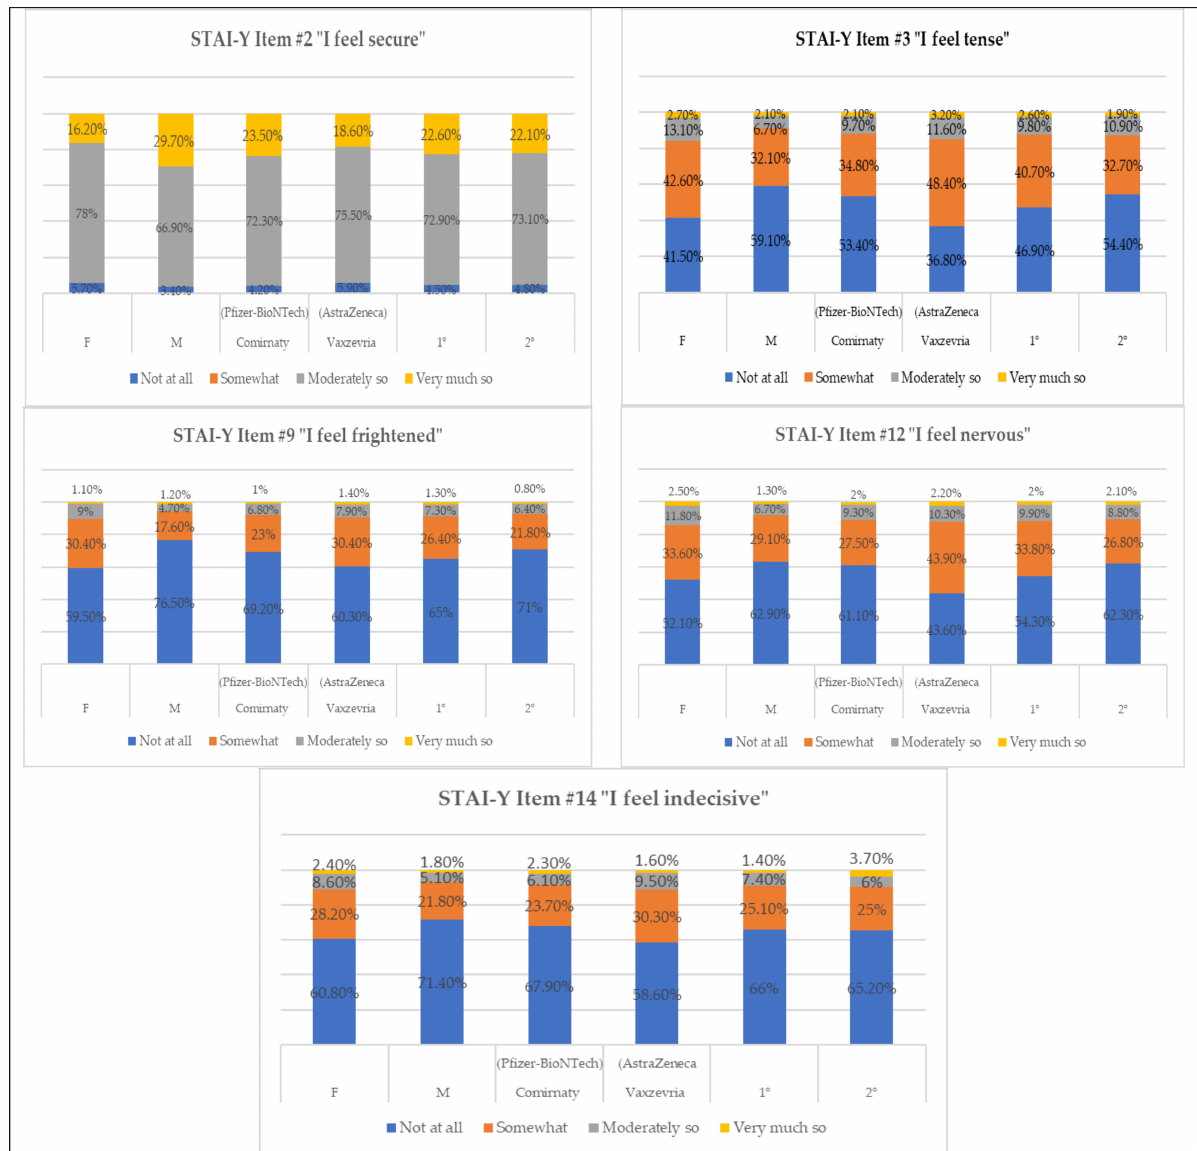
Figure 3. Percentage of response frequencies relative to items of STAI-Y divided by variable. Finally, with respect to the second objective, that is, to conduct a correlational anal- ysis between the psychological factors and the variables investigated, an ANOVA was performed between the PCS and MCS components of the SF-12, using the cumulative average of the STAI-Y scale 1 scores and the variables considered. Vaccine type signifi- cantly correlated with sex ( p = 0.079 **), PCS ( p = 0.175 **), MCS ( p = 0.151 **), and STAI-Y ( p = 0.115 **). PCS correlated significantly with MCS ( p = 0.504 **) and STAI-Y ( p = 0.182 **). The same effect also emerged in the correlation between STAI-Y and age ( p = − 0.102 **), in which the anxiety index decreased as the reference age range decreased. For the cate- gories, we found numerous significant correlations with both sex ( p = 0.100 **), the type of vaccine ( p = 0.352 **), and STAI-Y ( p = 0.134 *), whereas the results showed negative correlations with other variables, such as age ( p = − 0.199 **), dose received ( p = − 0.293 **), PCS ( p = − 0.075 **), and MCS ( p = − 0.180 **). As shown in Table 8, very low (roughly